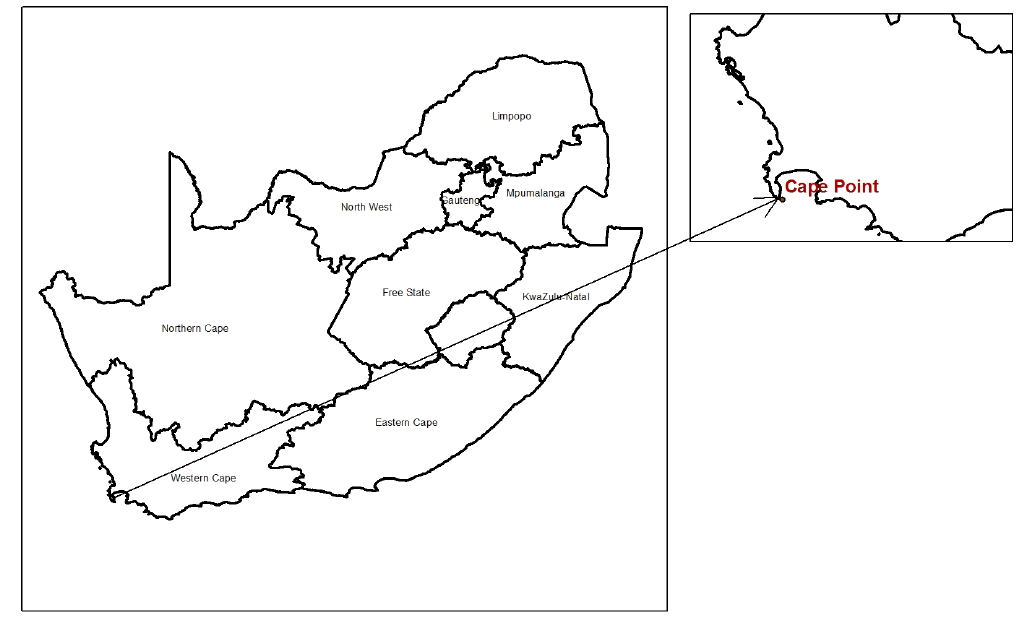
Figure 1. The map of South Africa and the location of the SAWS Cape Point Weather station in the Western